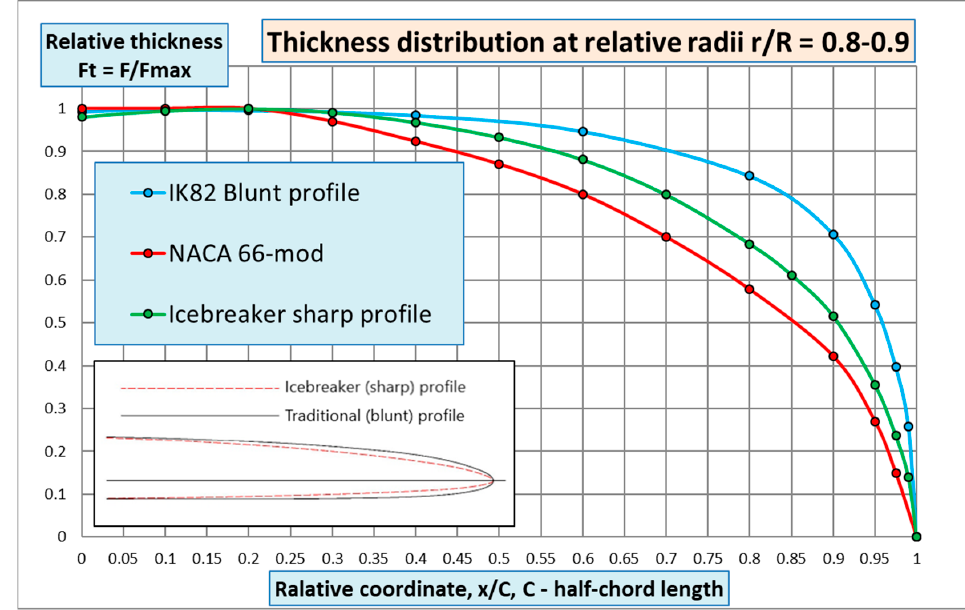
Figure 1. Thickness distribution for profiles of type IK82 (blunt profile), NACA 66-mod, and icebreaking profile.